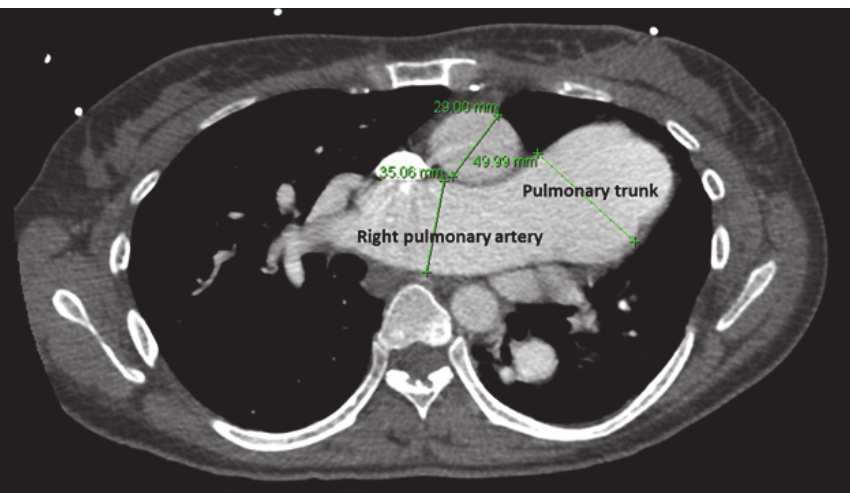
Figure 2: Computed tomographic angiography of the chest shows a markedly dilated pulmonary trunk, at 49.99 mm (normal < 30 mm); a pulmonary trunk-to-aorta ratio of 1.7 (normal < 1.0); and an enlarged right pulmonary artery, at 35.06 mm (normal < 20 mm).